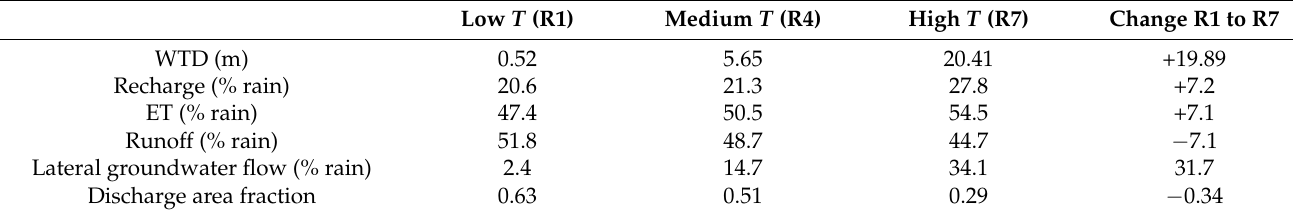
Table 4. Modelled mean fluxes as a percentage of mean rainfall between the low (R1), medium (R4) and high (R7) T models on the 0.05 ◦ grid.